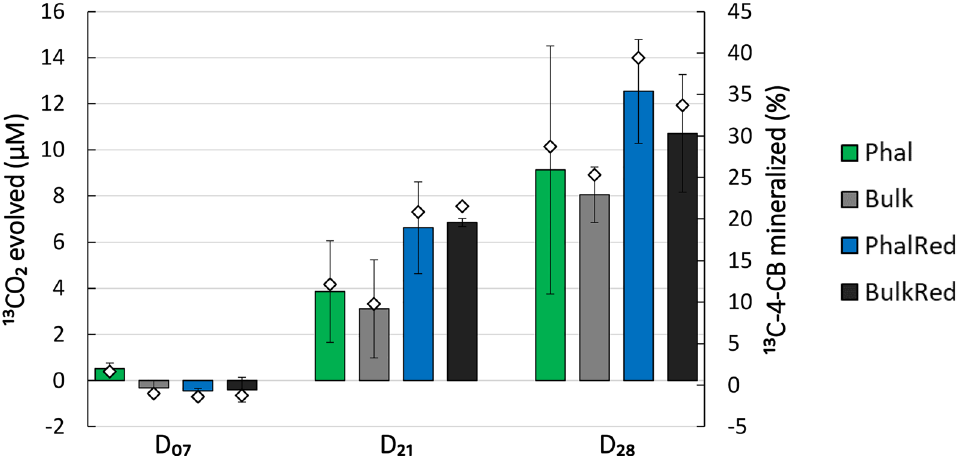
Figure 1. Amounts of 13 CO 2 (bars, left axis) evolved after 7, 21 and 28 days of soil incubation with 13 C-4- chlorobiphenyl and percentage amount of original substrate that was converted to 13 CO 2 (white diamonds, right axis). Error bars represent standard deviations for 13 CO 2